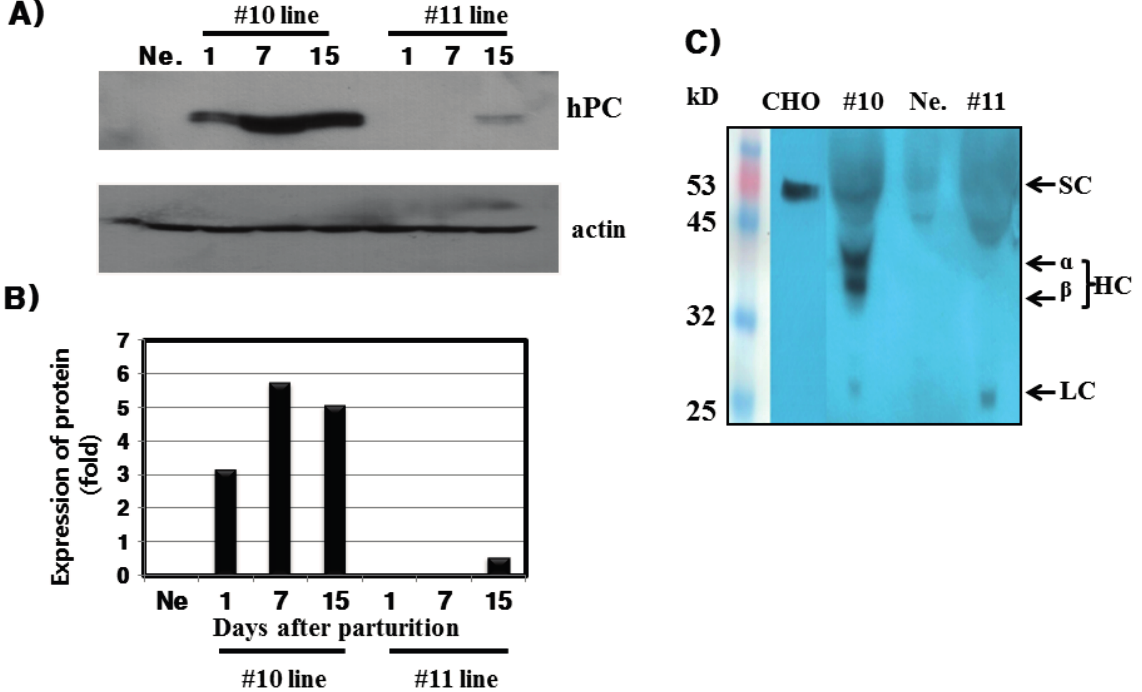
Figure 4. Western blot analysis of hPC from the mammary glands and milk during lactation. ( A ) Protein detection from mammary glands during lactation; ( B ) The quantity analysis of hPC expressed in the mammary glands; ( C ) hPC protein detection assessed in the milk of the #10 and #11 lines via Western blot. SC: single-chain hPC forms; HC: heavy-chain hPC form; LC: light-chain hPC forms; CHO: hPC expressed into the CHO cells transfected with hPC